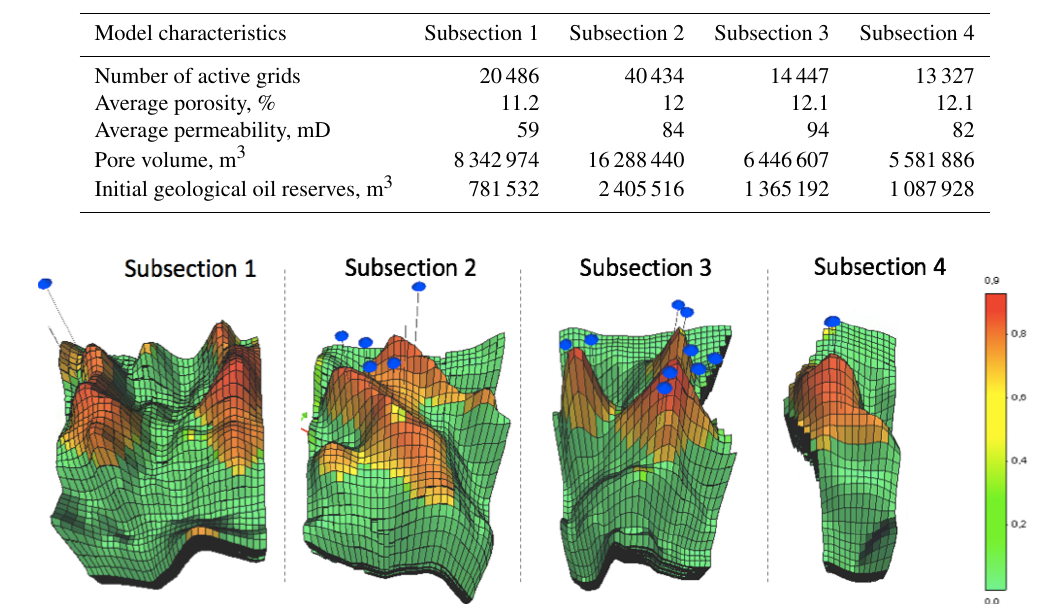
Figure 6. Oil saturation distribution of different